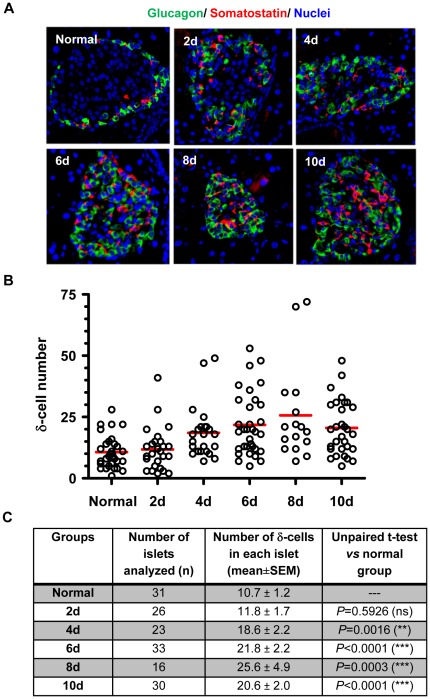
The distribution of α-cells and δ-cells following STZ treatment.The pancreatic islets from normal and STZ-treated mice were co-stained with anti-glucagon (green) and anti-somatostatin (red) antibodies. A: representative images showing δ-cells expanded in a similar pattern to α-cells following STZ treatment. B: Quantitative distribution of δ-cells in each islet group. The quantification of δ-cells was obtained the same way as described for α-cells and β-cells in Figures 1 and 2. The redlines represent the mean values for each islet group. C: the statistical summary of δ-cell distribution in islets from normal mice and STZ-treated mice. The mark ** indicates p<0.005, and *** indicates p<0.0005; ns: not significant.